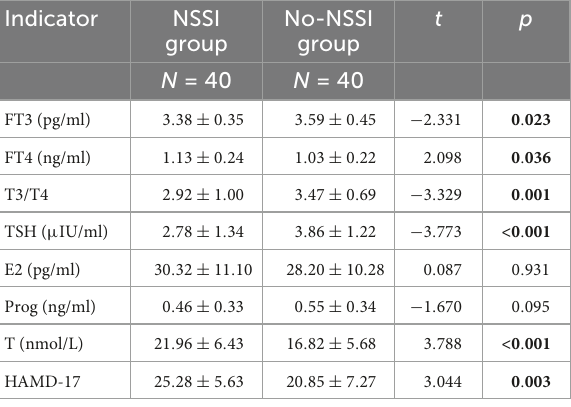
TABLE 1 Comparison of indicators at baseline between the two groups. Indicator